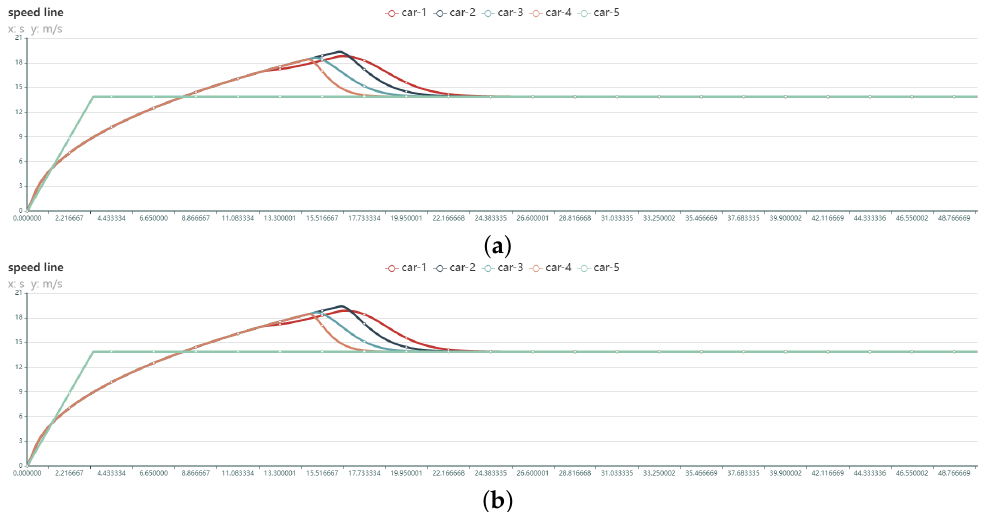
Figure 20. Speed variation curves of 5 vehicles in the convoy using different PID model control (with acceleration control): ( a ) P1 [ K v = 1.0, k a = 0.8, K g = 4.0 ] ( b ) P2 [ K v = 0.75, k a = 0.7, K g = 4.125 ]